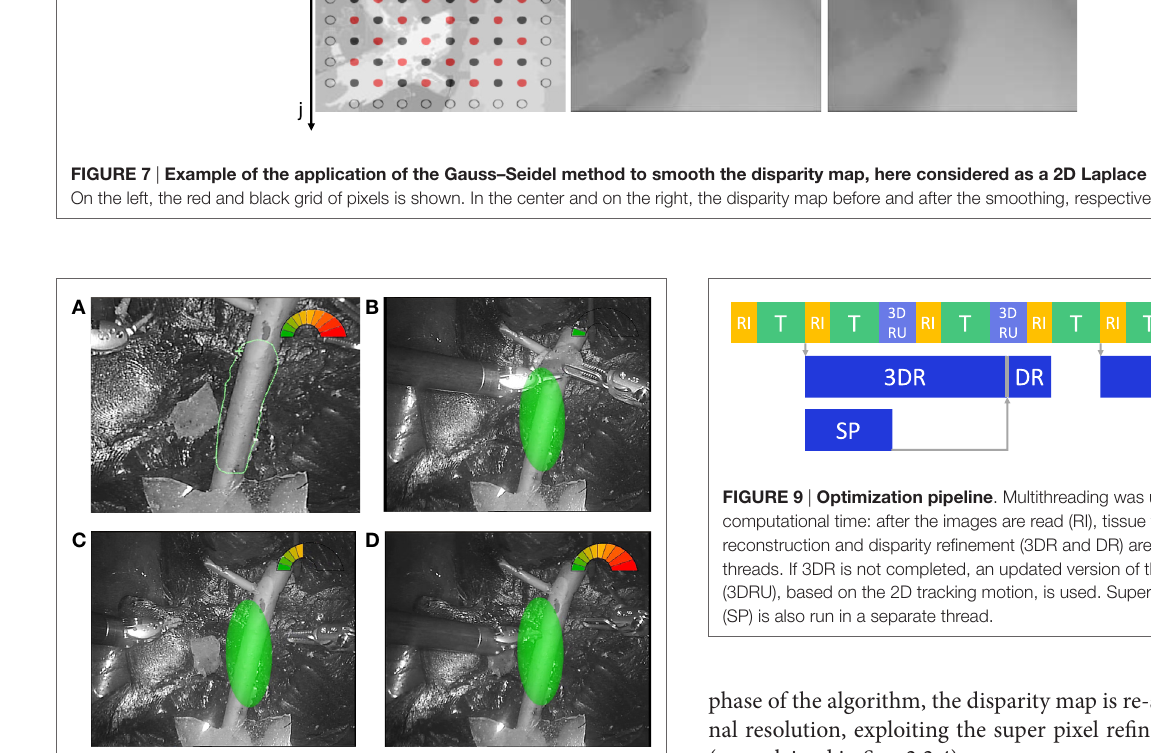
FigUre 8 | example of ar visualization . (a) The view of the SA definition; three different situations showing. (B) The instruments performing the surgery in the safe green range. (c) The right instrument approaching the delicate area. (D) The left instrument almost touching the vessel surface and the gage completely